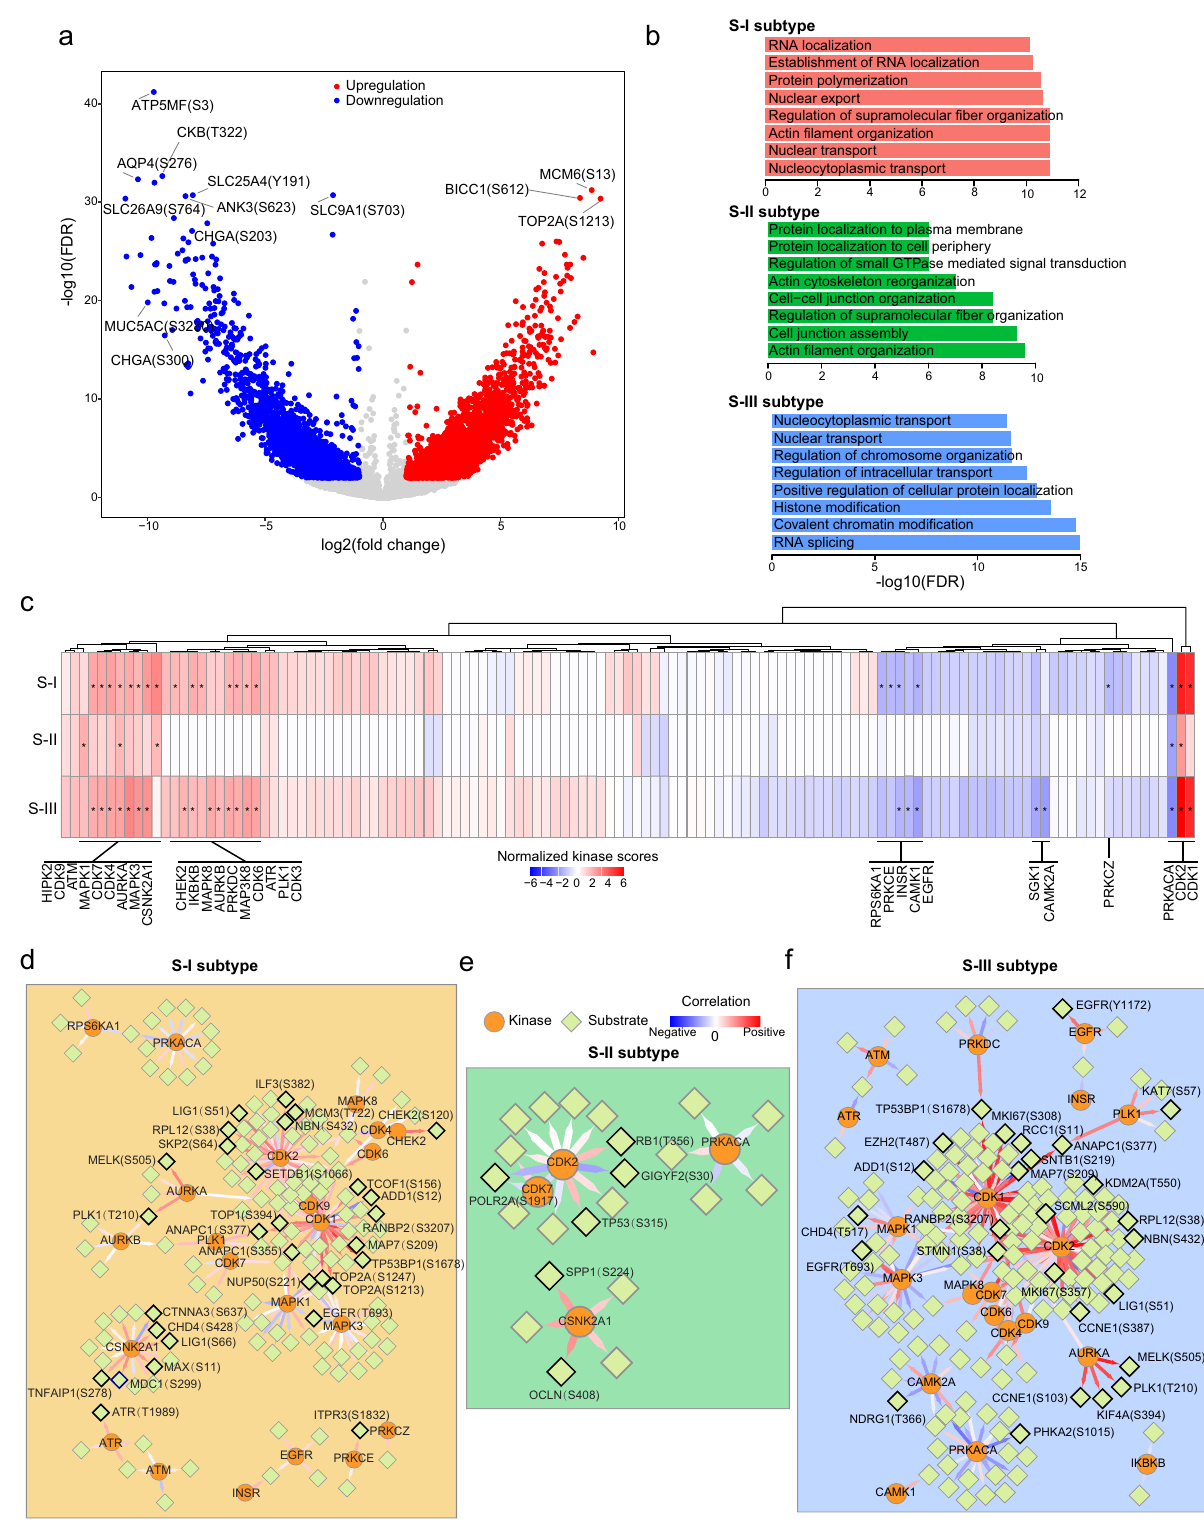
Fig. 7 | Phosphoproteomic analyses in three AEG subtypes. a Volcano plot showing the differential signi fi cance of phosphorylation sites. Red circles represent sites with increased phosphorylation (FDR< 0.01 and log2(fold change)>1) and blue circles indicate downregulated phosphorylation sites (FDR < 0.01 and log2(fold change)< − 1). b Enriched biological processes of